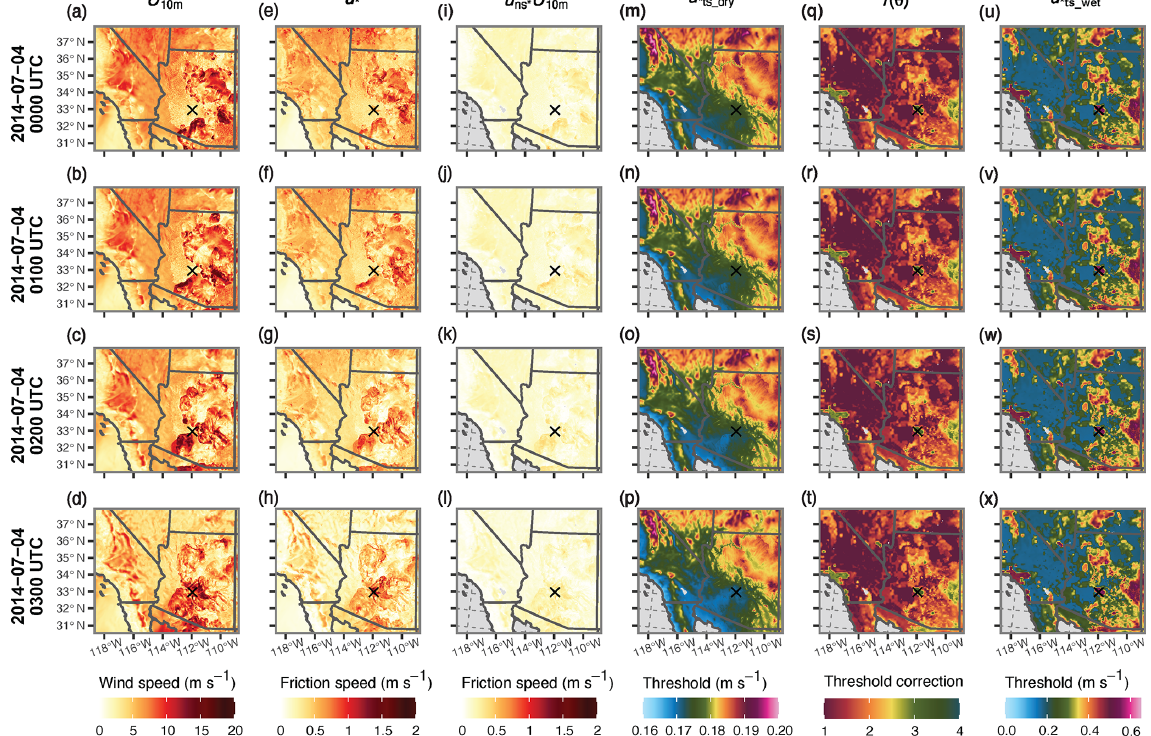
Figure 9. Times series of simulated (a–d) 10m wind speed ( U 10m ; ms − 1 ), (e–h) total wind friction speed ( u ∗ ; ms − 1 ), (i–l) surface friction speed determined from the albedo-based drag parameterization ( u s ∗ ; ms − 1 ), (m–p) threshold friction speed for a 69µm diameter particle for an idealized smooth, dry, and barren soil surface ( u ∗ ts (D s , p = 69µm); ms − 1 ), (q–t) the soil-moisture-based correction function ( f (θ) ; dimensionless), (u–x) and soil-wetness-corrected threshold friction speed for a 69µm diameter particle ( u ∗ ts (D s , p = 69µm, θ ); ms − 1 ) from 00:00 to 03:00UTC on 4 July 2014. The u ∗ ts_dry and u ∗ ts_wet symbols used in the figure labeling represent u ∗ ts (D s , p = 69µm) and ( u ∗ ts (D s , p = 69µm, θ ), respectively. The wetness-corrected threshold is the product of the threshold friction speed and the soil-moisture- based correction function. Note the differences in color bar scaling. The black × marks the location of Phoenix,